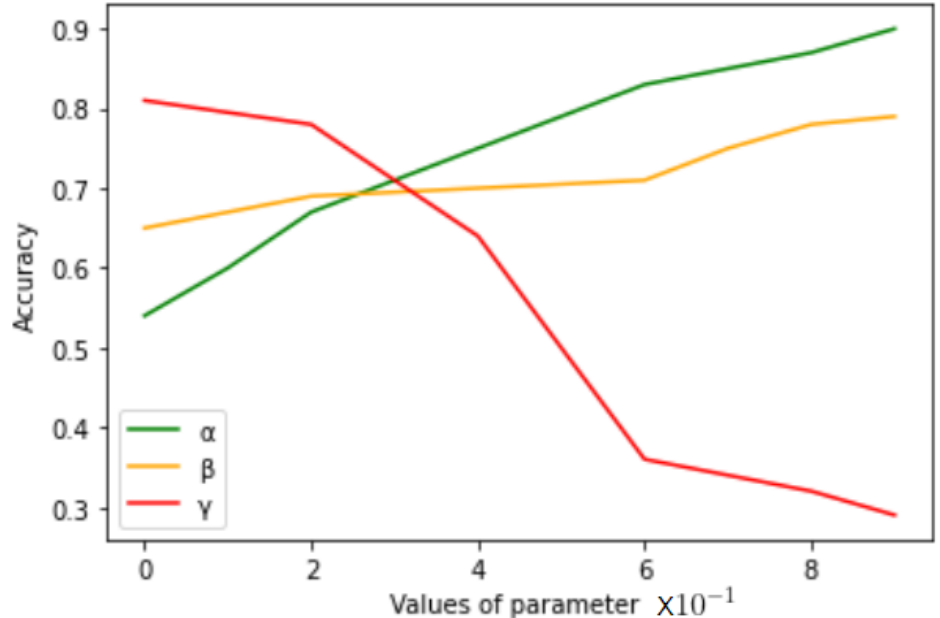
Figure 7. Variation of irrelevance sampling parameters α , β and γ